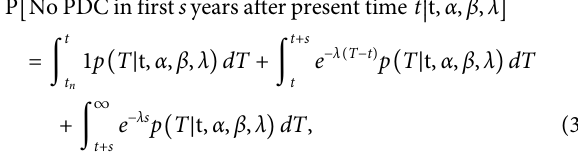
Frontiers in Earth Science |